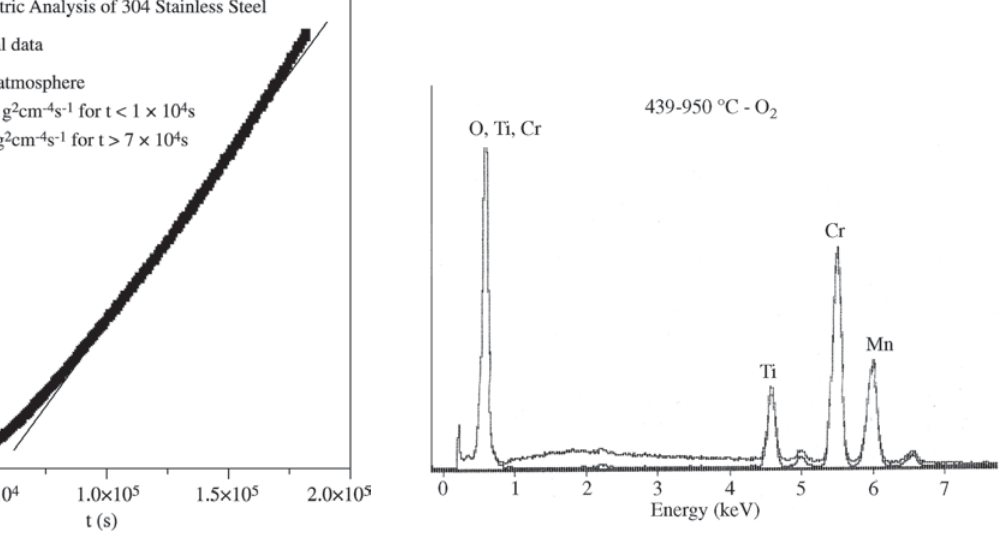
Figure 4. EDX analysis on the surface of the 439 steel oxidized at 950 °C in oxygen showing that the oxide scale contains Cr, Ti and Mn.